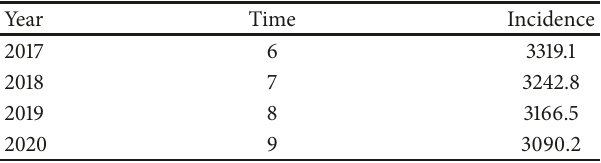
Table 4: Forecasting trend of diarrhea incidence from